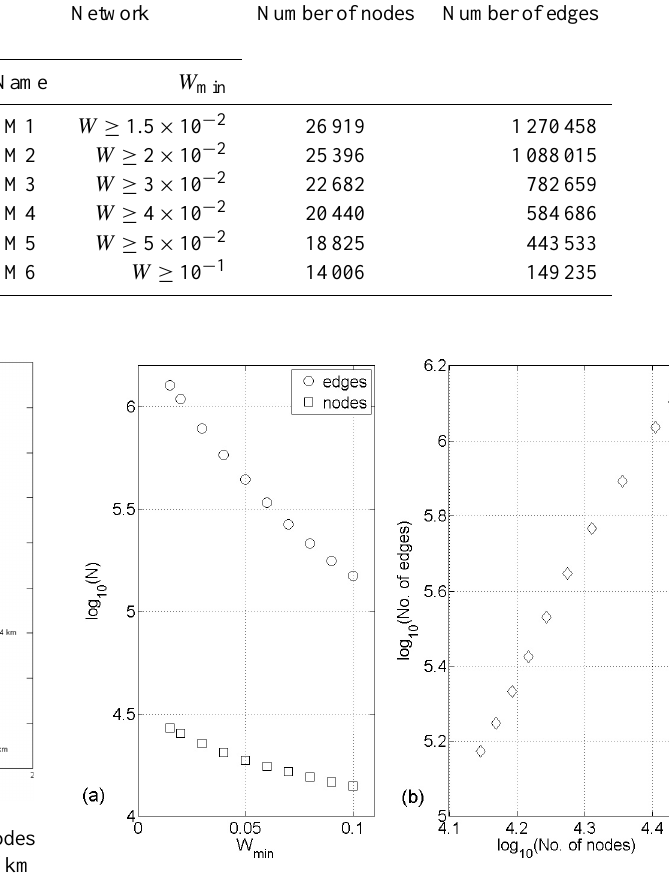
Fig. 7. Class M networks. (a) The dependency of the number N of edges (circles) and the number N of nodes (squares) on the mini- mum weight W min . (b) The dependency of the number of edges on the number of